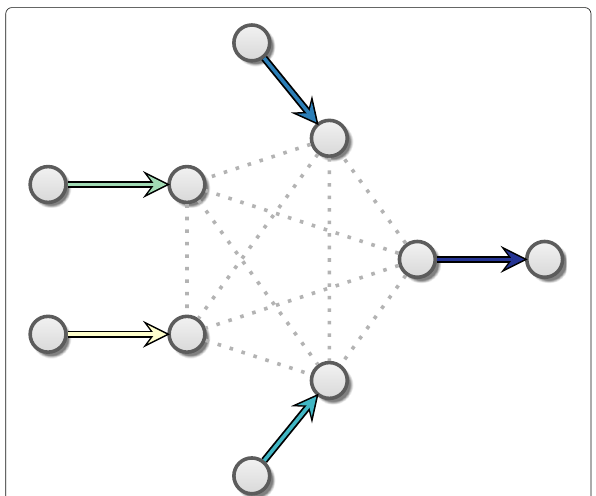
Fig. 12 A schedule that requires a coloring with five colors